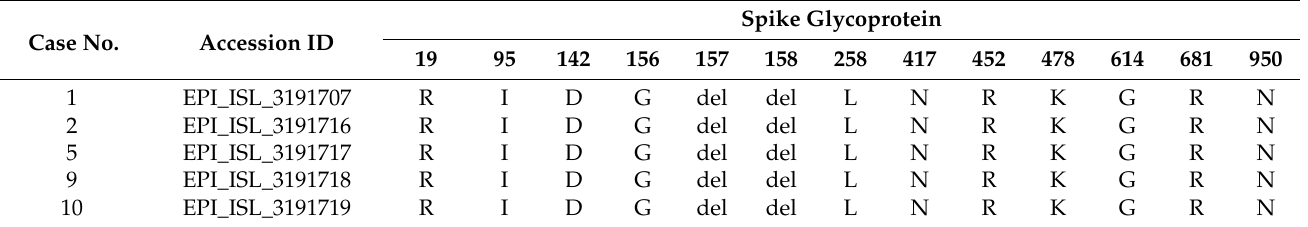
Table 2. GISAID accession ID and amino acid mutations in the spike glycoprotein.